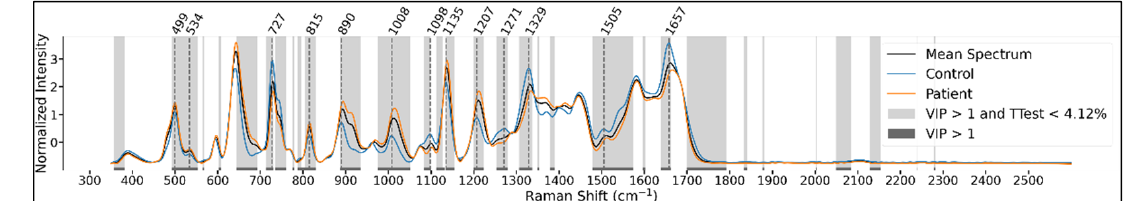
Figure 5. Mean spectra with emphasized t-test significance and VIP > 1 for serum samples.